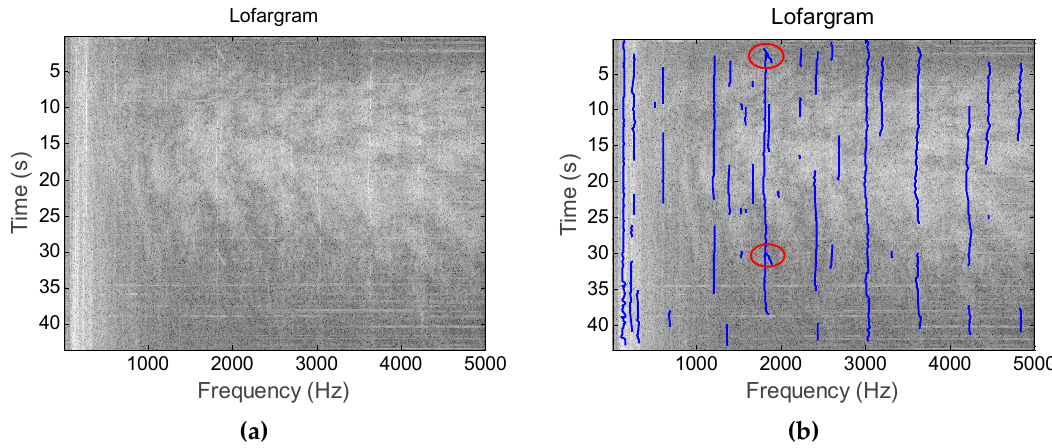
Figure 21. Line extraction in the actual signal containing the pulse signal component: ( a ) Initial lofargram; ( b ) Tracking results.